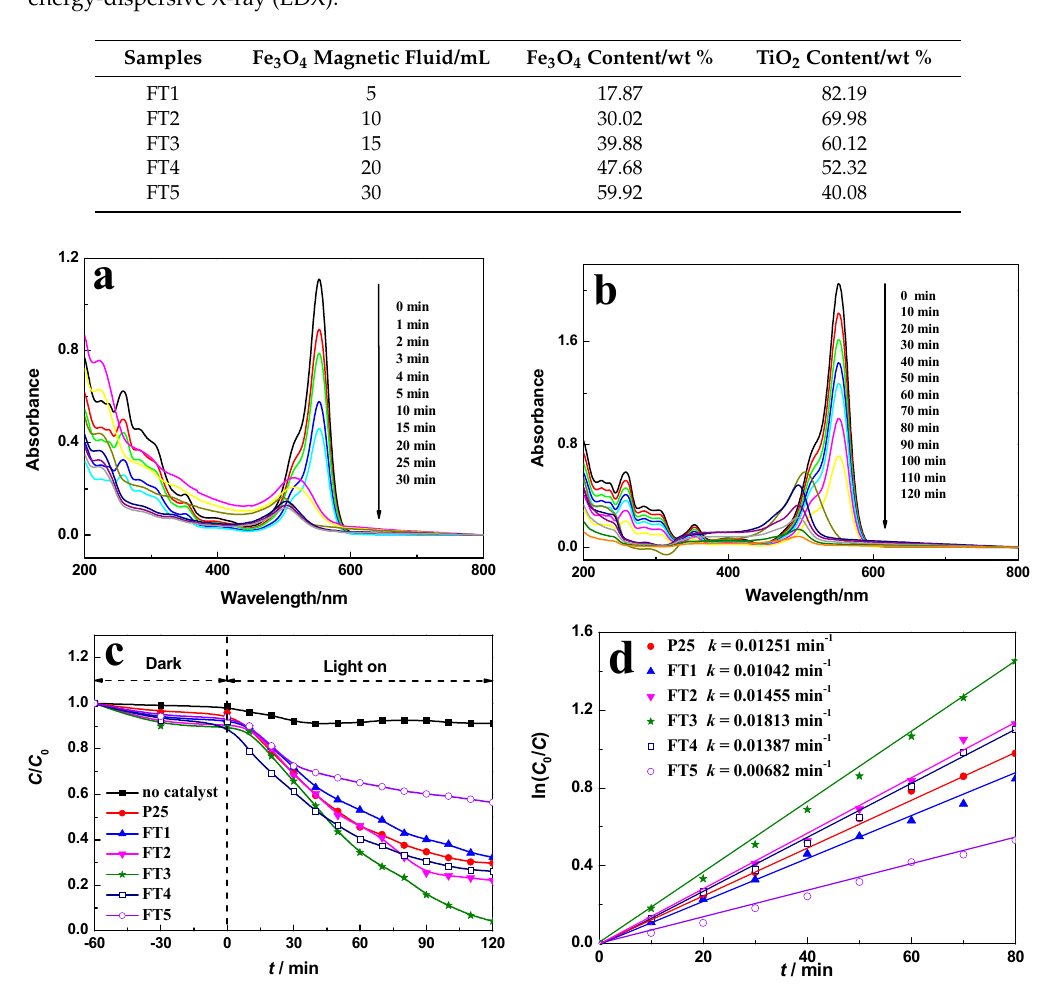
Table 2. Fe 3 O 4 and TiO 2 contents of the as-prepared Fe 3 O 4 /TiO 2 nanocomposites detected by energy-dispersive X-ray (EDX).